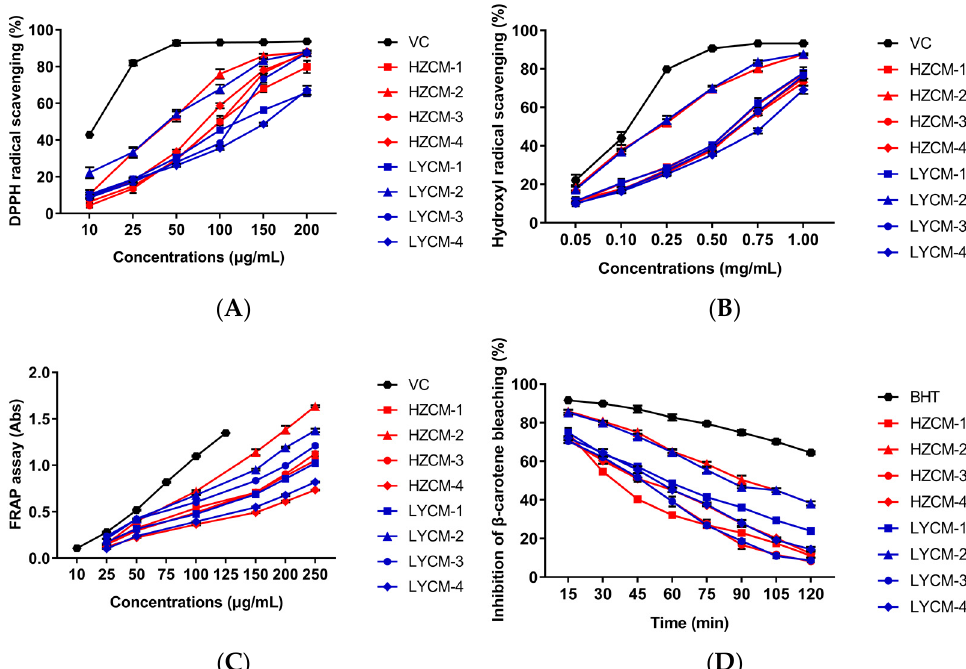
Figure 1. In vitro antioxidant effects of Cortex Moutan extracts. Effects of Cortex Moutan (CM) extracts on DPPH scavenging ( A ), hydroxyl radical scavenging ( B ), FRAP assay ( C ), and inhibition of β -carotene bleaching ( D ). Vitamin C: VC; HZCM-1, HZCM-2, HZCM-3, and HZCM-4: CM collected